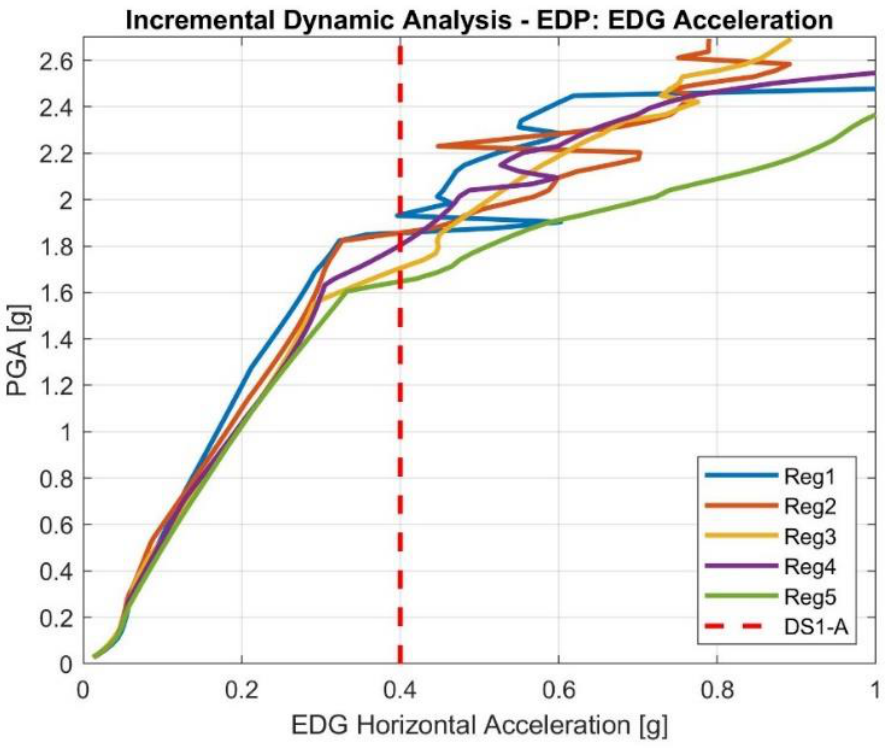
Figure 12. IDA for EDG acceleration EDP. Table 6. IDA results for the EDG acceleration EDP.